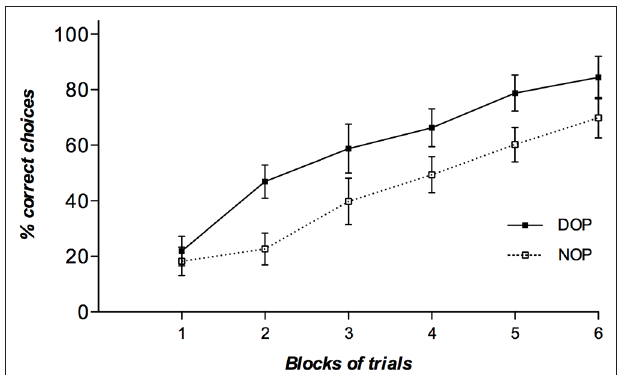
FIGURE 2 | Mean percentages of correct choice responses obtained by participants in the learning phase of Experiment 1A as a function of blocks of trials (six blocks of 16 trials each) and outcomes (DOP and NOP). Error bars show the standard error of the mean.